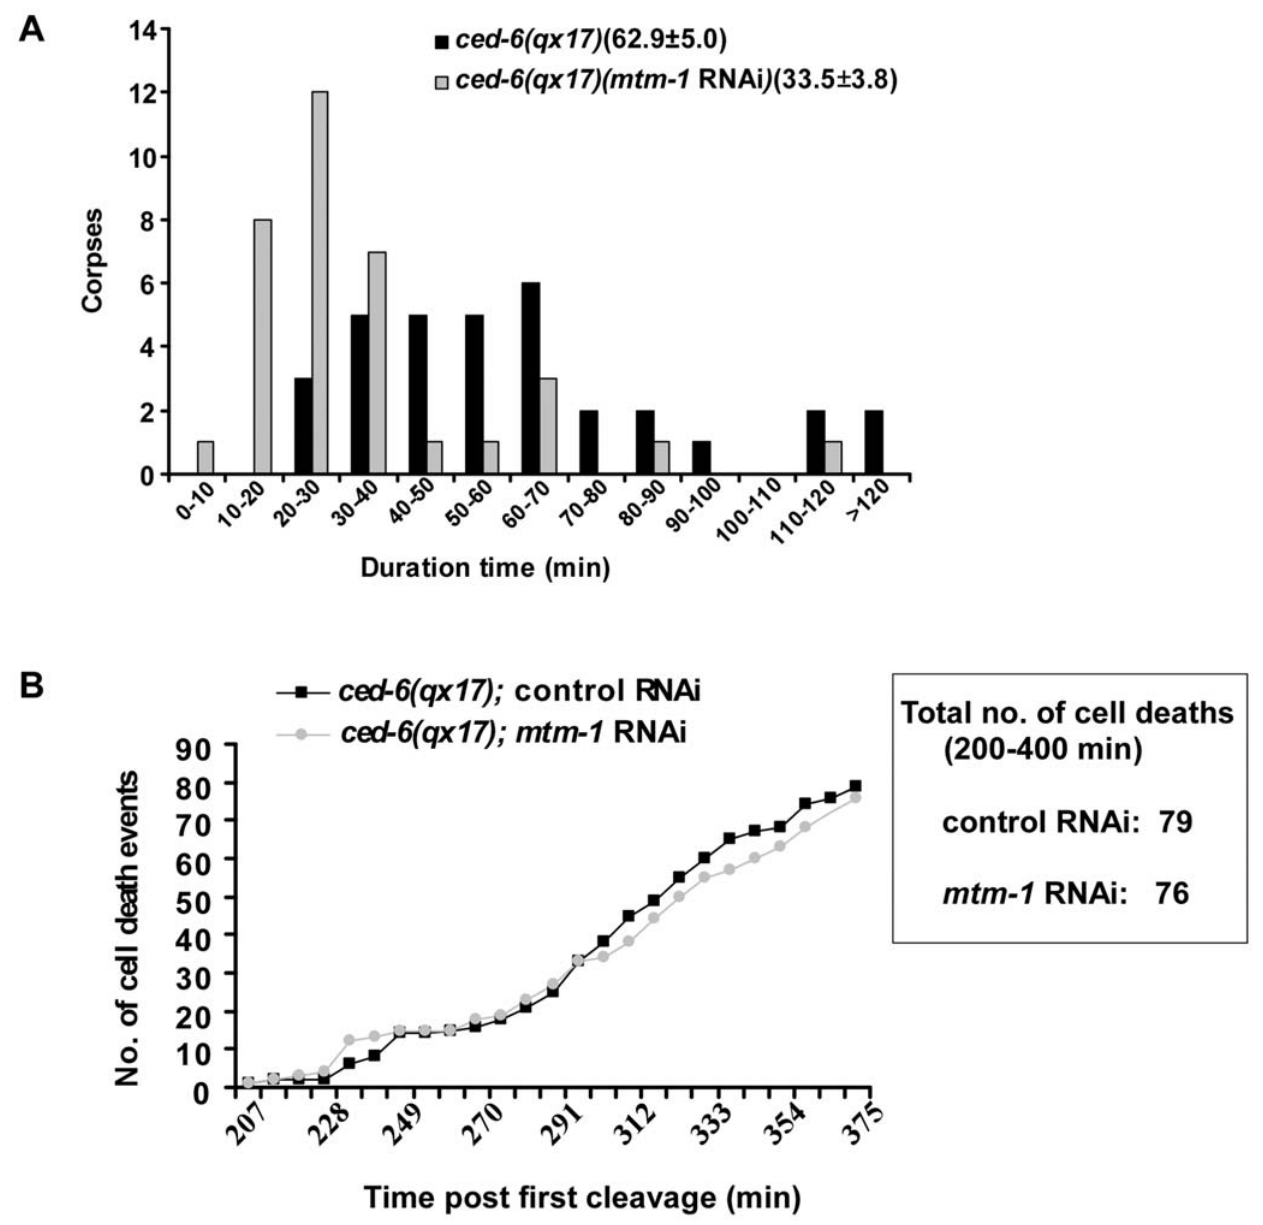
Figure 2. Inactivation of MTM-1 accelerates cell corpse clearance. (A) Four-dimensional microscopy analysis of cell corpse duration was performed in ced-6(qx17) mutants (black) or ced-6(qx17);mtm-1 ( RNAi ) worms (gray). The duration of 33 cell corpses in ced-6(qx17) animals (n=4) and 35 cell corpses in ced-6(qx17);mtm-1 ( RNAi ) animals (n=3) was monitored. The numbers in parenthesis indicate the average duration of cell corpses ( 6 s.e.m). The y -axis represents the number of cell corpses within a specific duration range as shown on the x -axis. (B) mtm-1 RNAi does not affect cell death occurrence. Embryonic cell deaths occurring between 200 and 400 min post first cleavage were followed in ced-6(qx17) mutants treated with either control RNAi (black) or mtm-1 RNAi (gray). The y -axis indicates the total number of cell death events observed at different time points as shown on the x -axis.